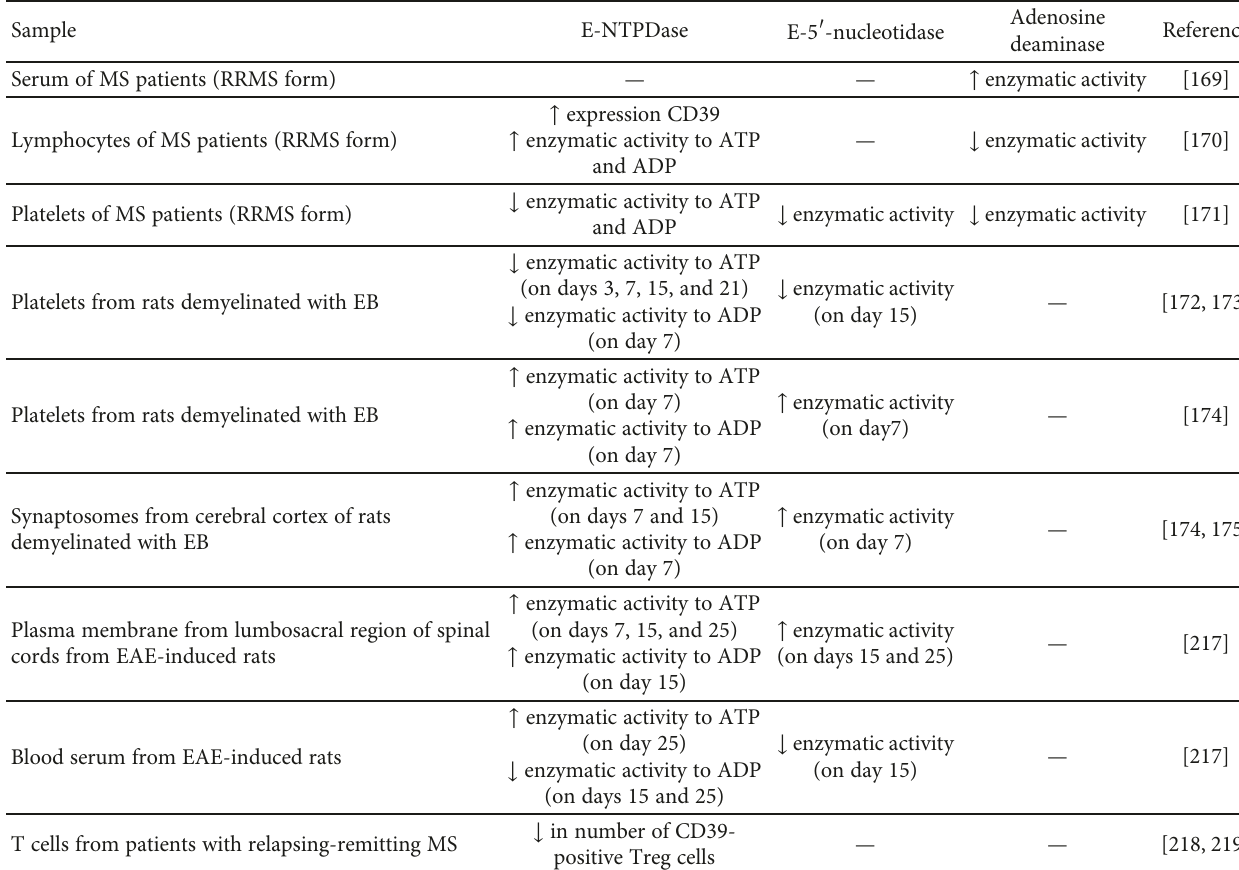
Table 6: Ectonucleotidases (E-NTPDase, E-5 ′ -nucleotidase, and ADA) in experimental models and patients with MS: a review.